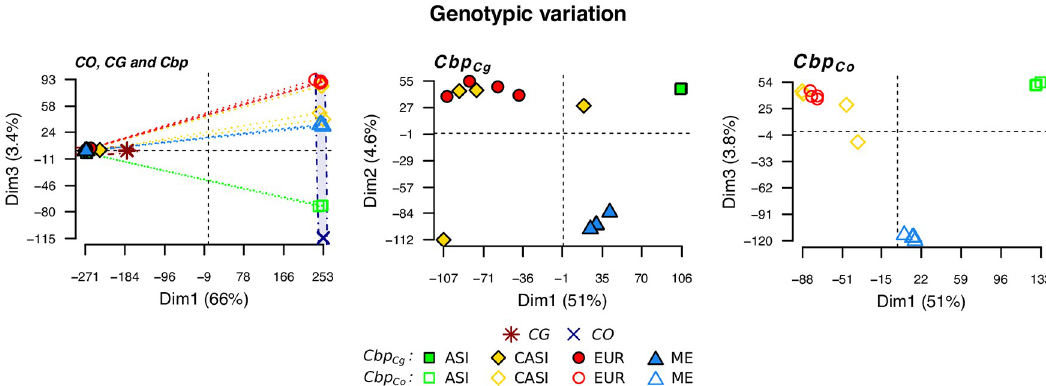
Fig 2. Genomic variation patterns in three Capsella species. Variation was visualized with principal component analyses based on the SNPs of C. grandiflora ( CG ), C. orientalis ( CO ), and four populations of C. bursa-pastoris ( Cbp ) (Asia (ASI), Central Asia (CASI), Europ (EUR), and Middle East (ME)). The left plot shows variation in the three species with lines connecting subgenomes of corresponding Cbp accessions and the dash-dotted circles highlighting two subgenomes of Cbp . The middle and right plots show only the variation within the subgenomes of C. bursa-pastoris ( Cbp and Cbp Cg Co